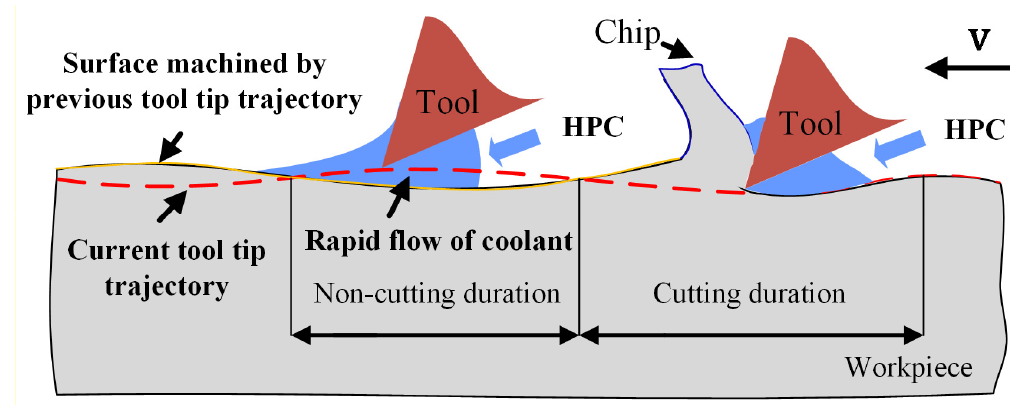
Figure 4. Cooling mechanism in HRUEM with a high-pressure coolant (HPC).